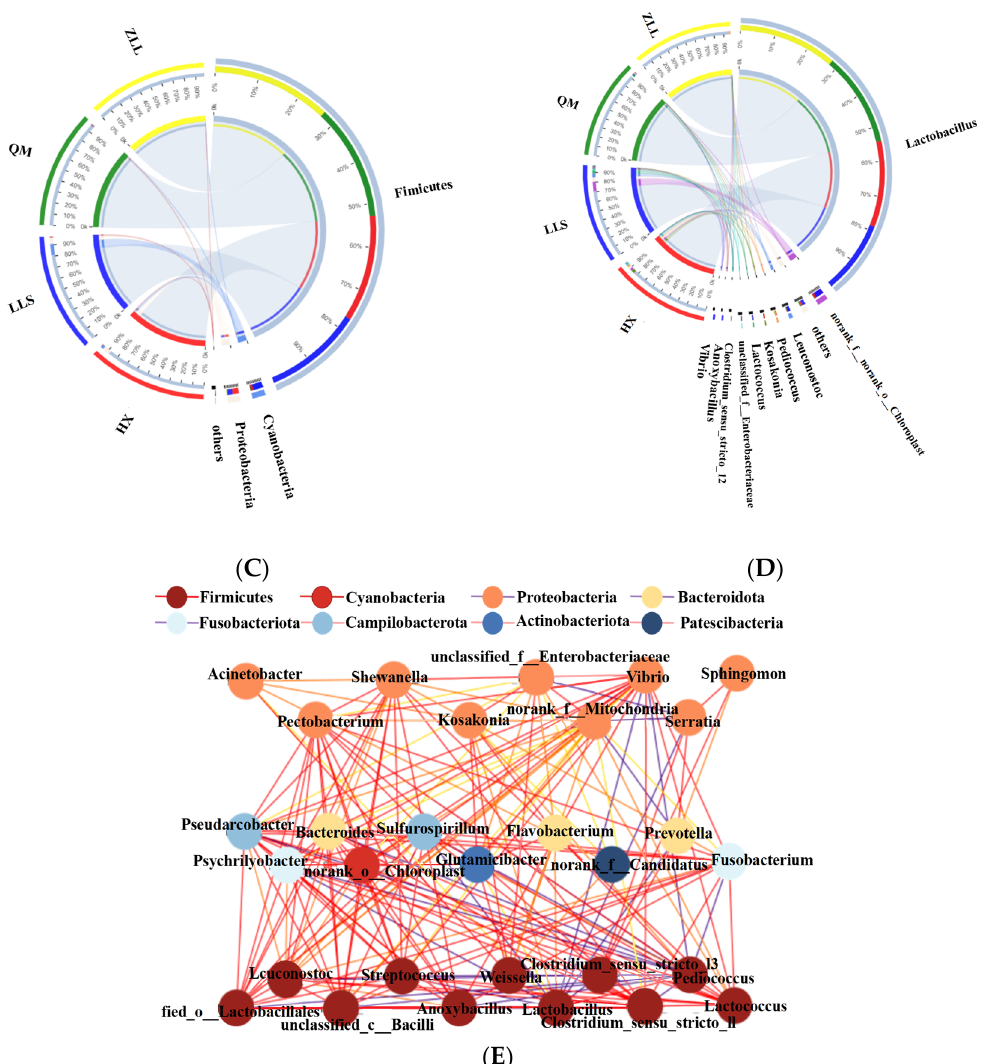
Figure 1. Microbial diversity analysis of sauerkraut. ( A ) Shannon and Simpson indices, ( B ) Chao1 and ACE indices, ( C ) phylum-level microbial composition, ( D ) genus-level microbial composition, ( E ) network analysis.